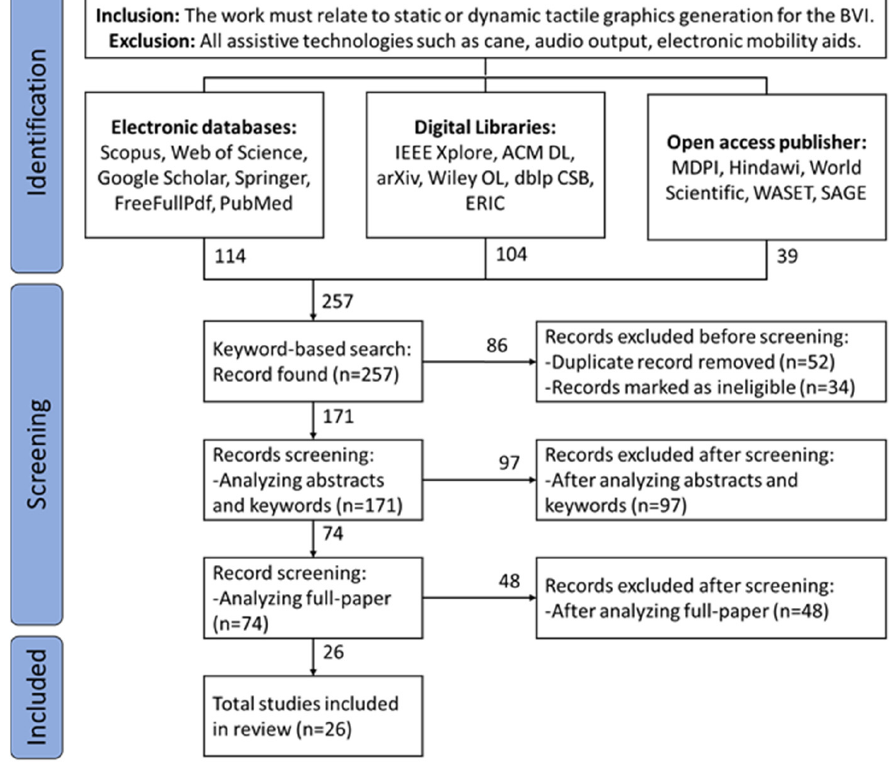
Figure 1. The flow diagram for the review process with the number of included and excluded articles in each step. A PRISMA flow diagram [47]. Table 1. Electronic databases and digital libraries used during the review